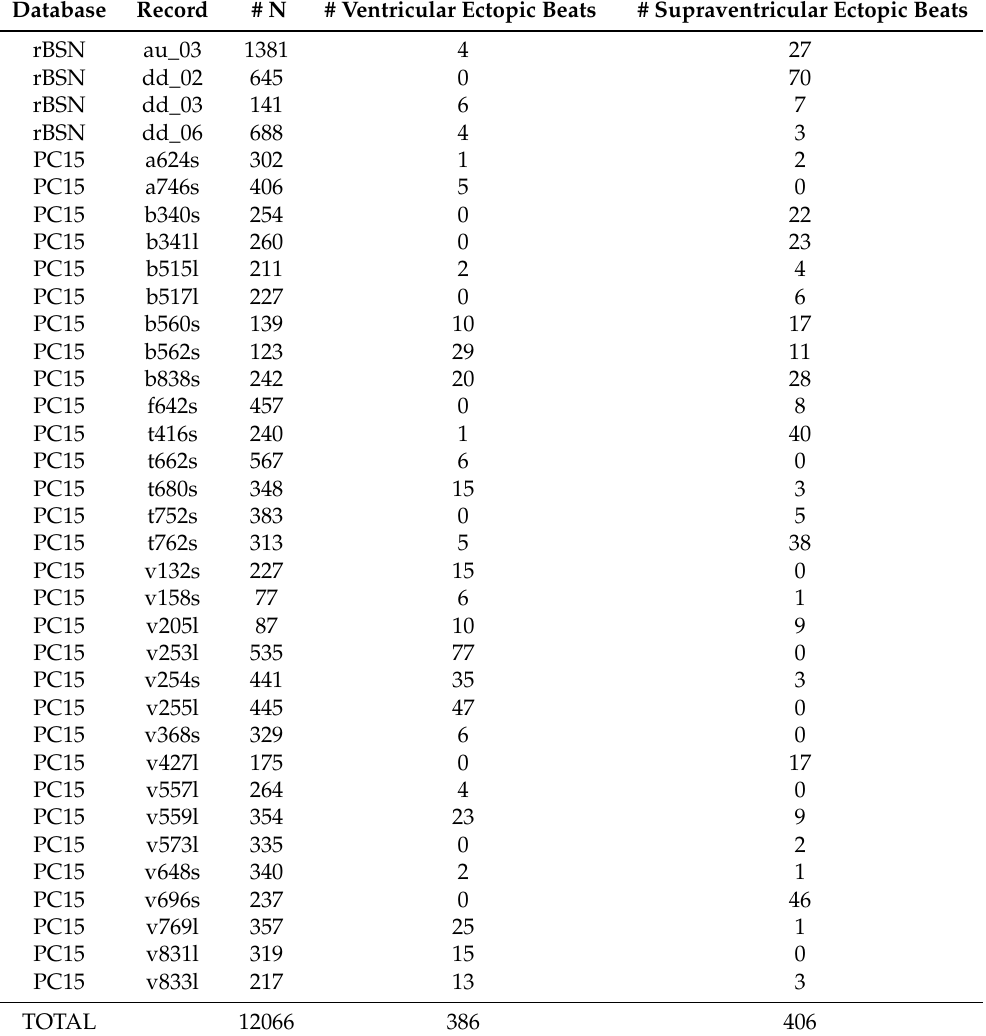
Table 5. Records used for evaluation of the ectopic beat detection algorithm. The database consists of data recorded as part of a small study using the referenced body sensor network as well as records drawn from the PhysioNet Challenge 2015 database [33].